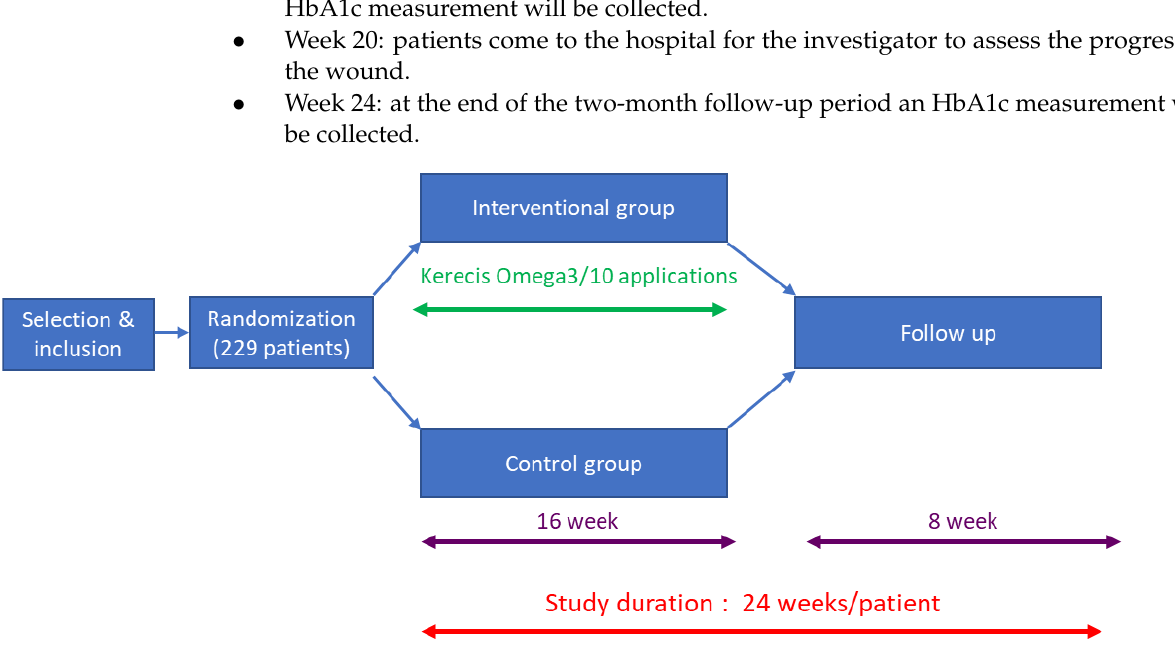
Figure 1. KereFish study design.